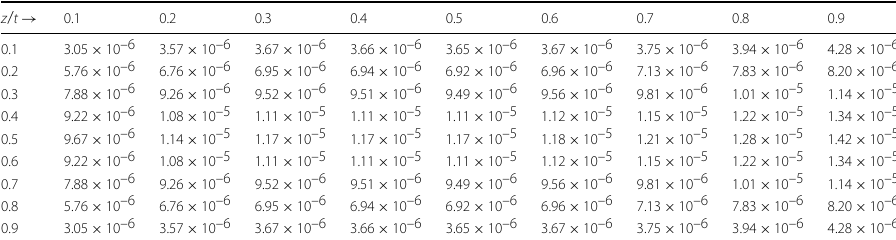
Table 5 Absolute errors for Example 1 by the proposed method at t = 1 when α = 0.9, N = 100, and (cid:3) t = 0.001